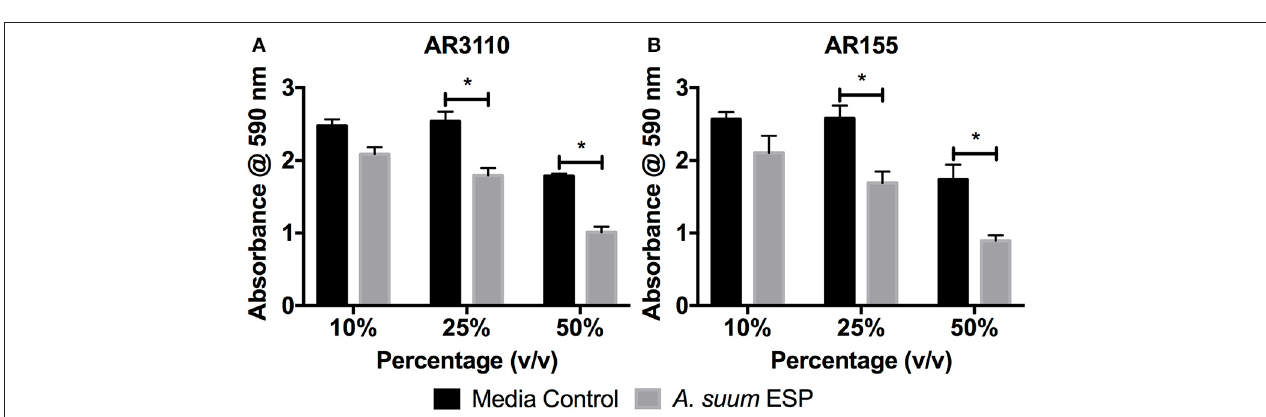
FIGURE 2 | Ascaris suum excretory/secretory products decrease biomass of submerged biofilms. Biofilm forming E. coli K-12 strains (A) AR3110 and (B) AR115 (a wcaE derivative of AR3110) were grown in 96-well cell culture plates in salt-free LB medium for 18h at 37 ◦ C in the presence of adult A. suum excreted/secreted products (ESP) or adult worm media (BSS) as a control. Treatment doses were added as a percentage (v/v) of final culture volume (total = 200 µ L per well). Results represented as the mean of three independent experiments ± SEM. Significance determined by 2-way ANOVA with Tukey’s multiple comparison tests, * p < 0.05.